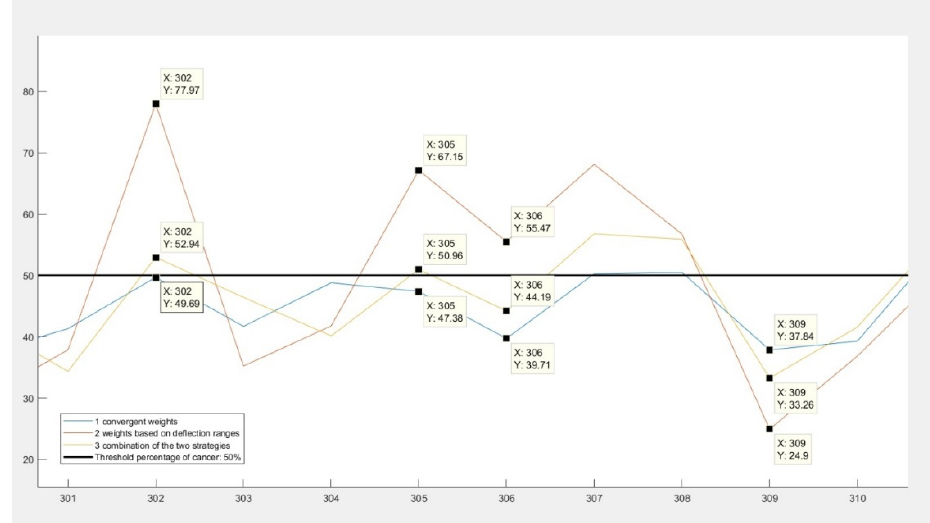
Figure 3. Third approach: combining the two previous strategies.